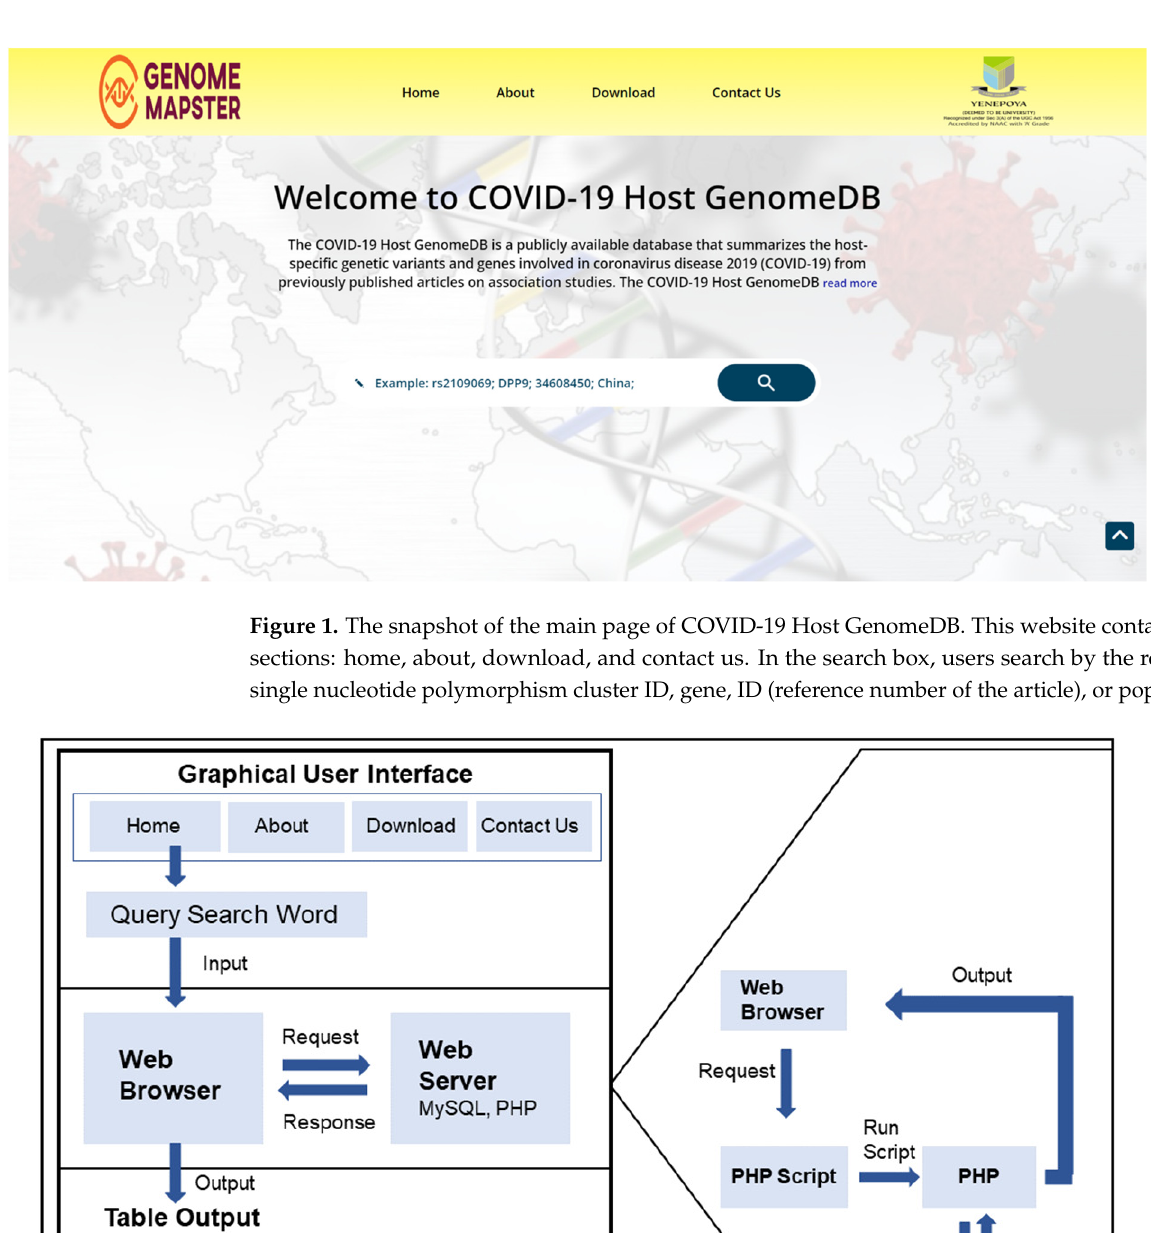
Figure 2. The basic workflow of the COVID-19 Host GenomeDB database. The user interface con- tains four sections: home, about, download, and contact us. On the main page, users search by ref- erence single nucleotide polymorphism cluster ID, gene, ID, or population. The search word input is transferred to the Hypertext Preprocessor (PHP) script and matched fields containing all the